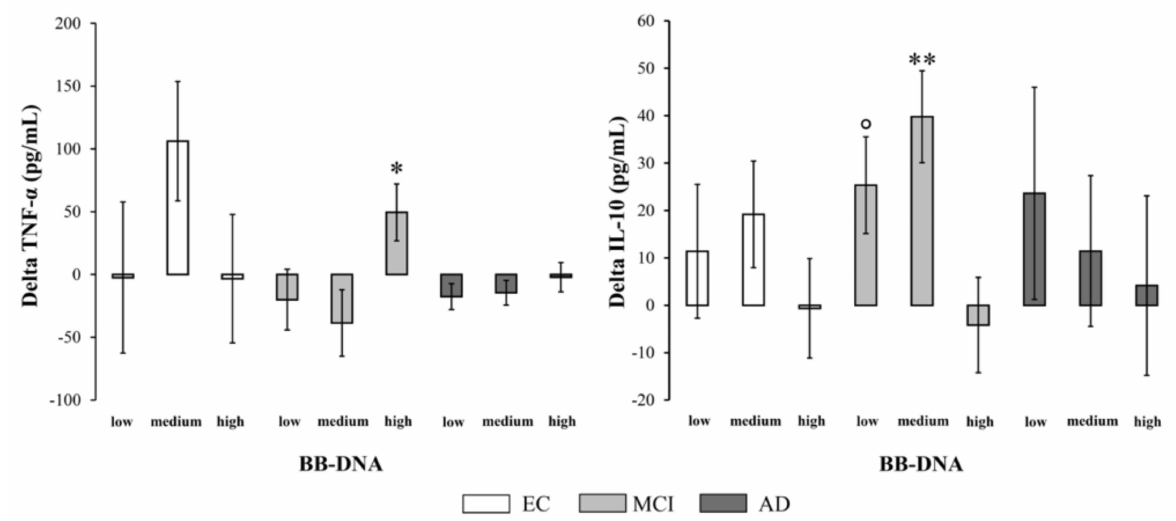
Figure 4. Changes in plasma TNF- α and IL-10 levels during the two-year follow-up in elderly controls (EC), mild cognitive impairment (MCI) and Alzheimer’s disease (AD) subjects in accordance with blood bacterial DNA (BB-DNA) tertiles. MCI patients showed a significantly higher TNF- α production and a significantly lower IL-10 production in BB-DNA high than in the other tertiles (i.e., BB-DNA medium and BB-DNA low ) after a two-year follow-up. ANCOVA analysis adjusted for age, sex, education, and IADL was applied. ** p <0.01 as compared to BB-DNA high ; * p < 0.05 as compared to BB-DNA low and BB-DNA medium ; ◦ p < 0.05 as compared to BB-DNA high